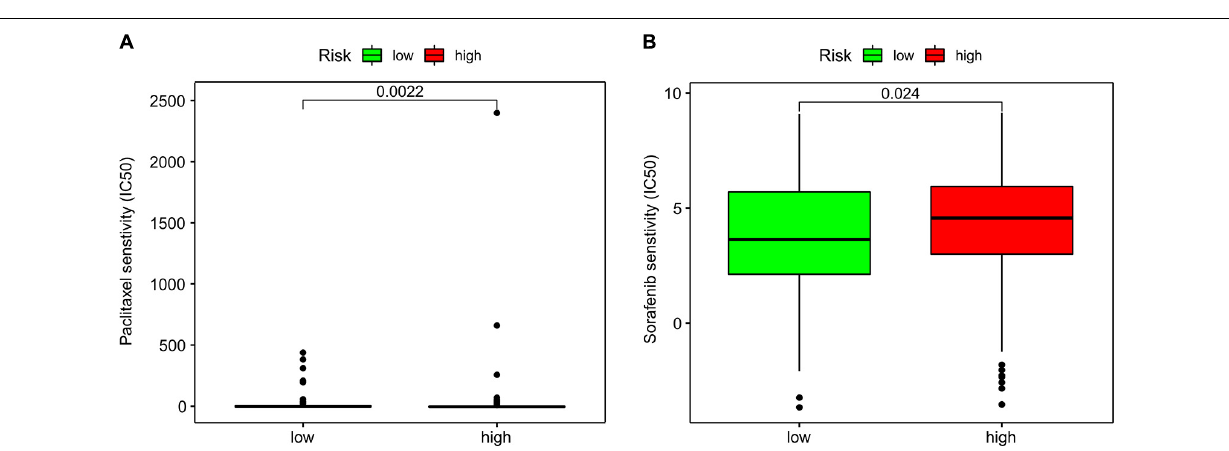
have incorporated genetic biomarkers for the complex